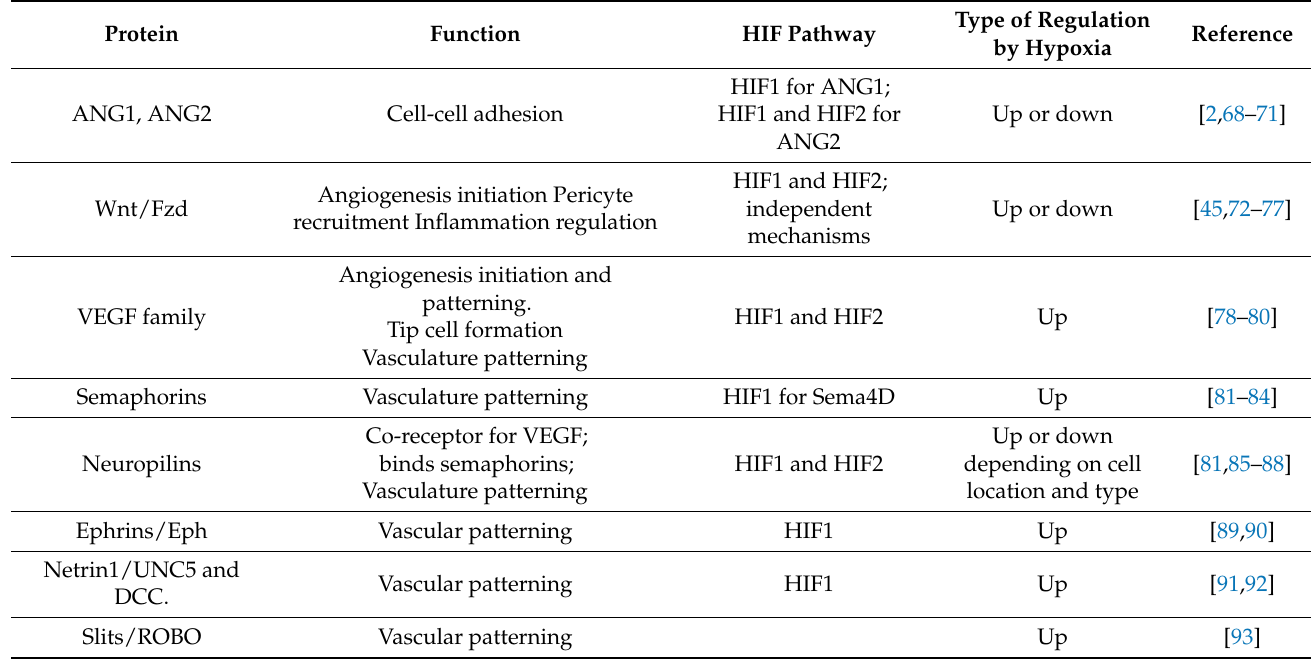
Table 1. Overview of hypoxia-related proteins involved in